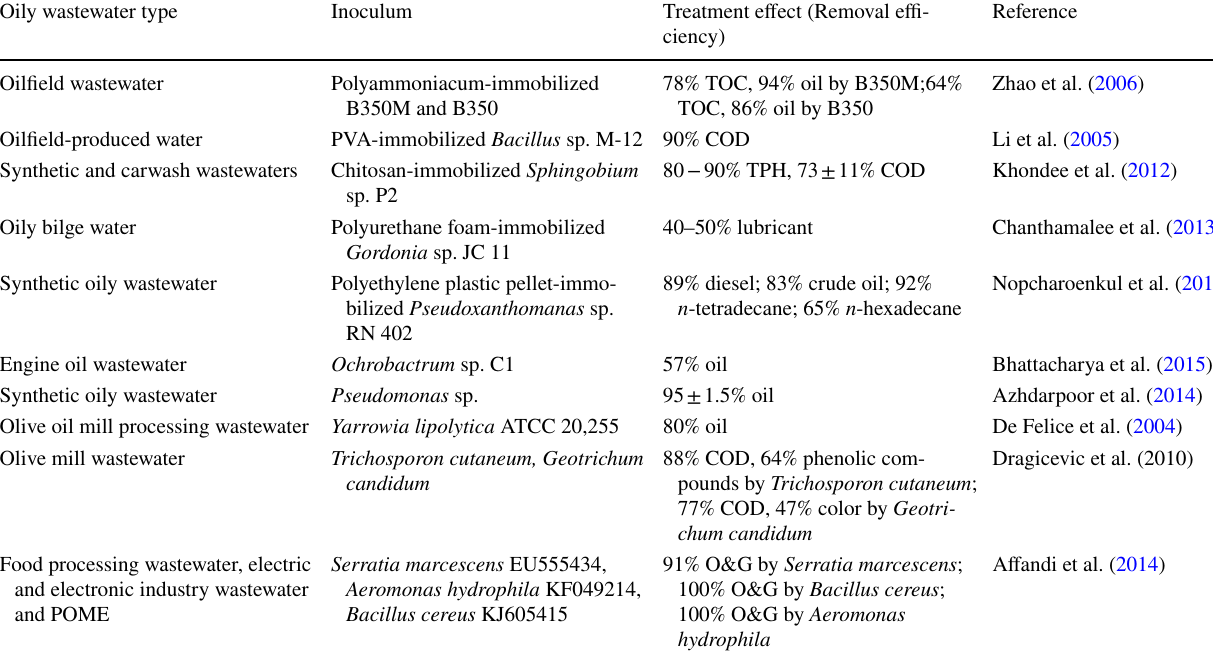
Table 2 Efficiencies of bioremediation in the removal of pollutants from oily wastewater Oily wastewater